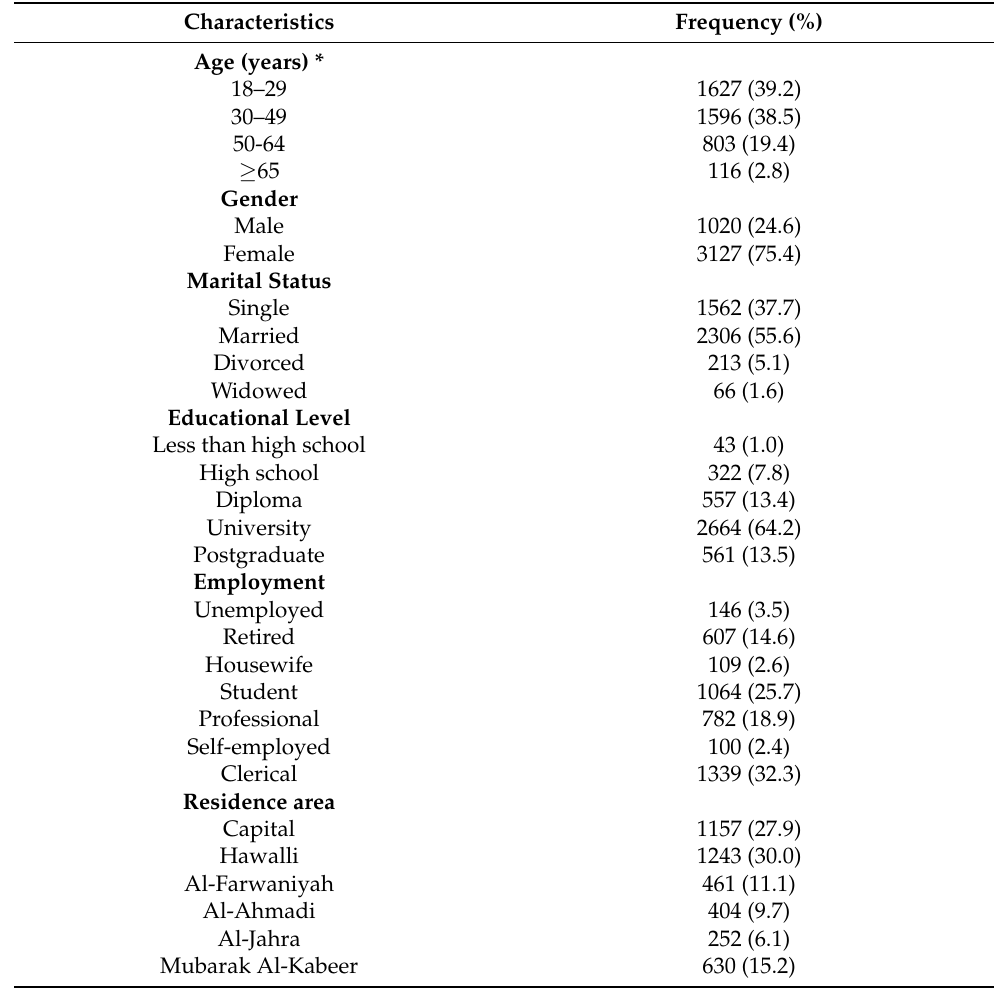
Table 1. Sociodemographic and other characteristics of the respondents ( n =